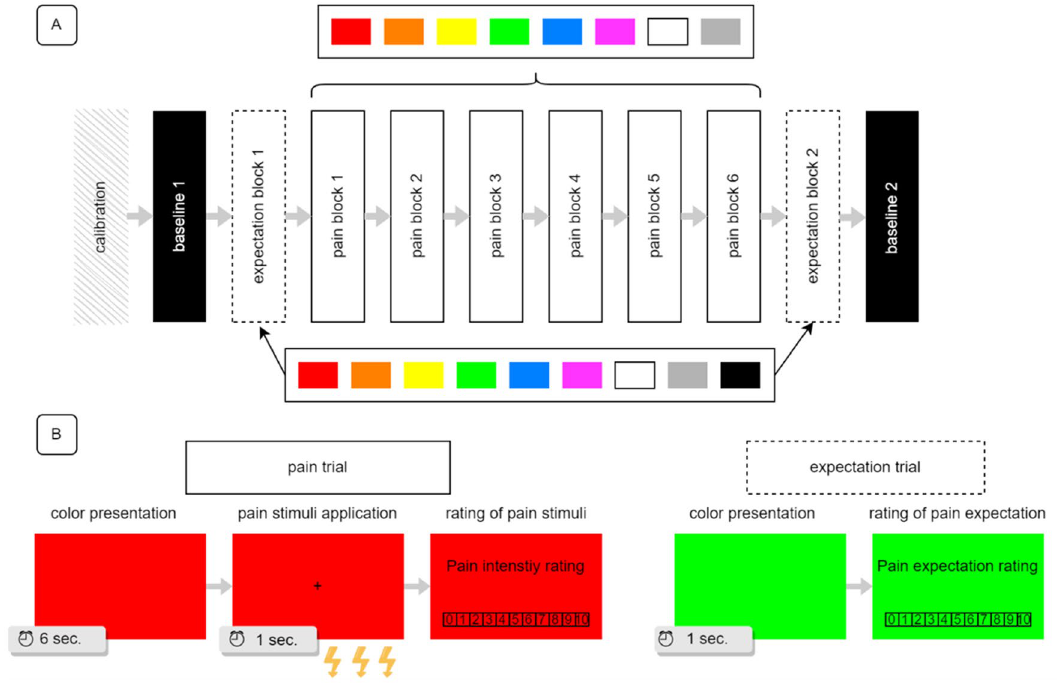
Figure 3. Study design. The study involved two groups that differed in the modality of pain applied: thermal or electrical. Part ( A ) of the figure shows the study flow. Part ( B ) shows a sample pain and expectation trial design.